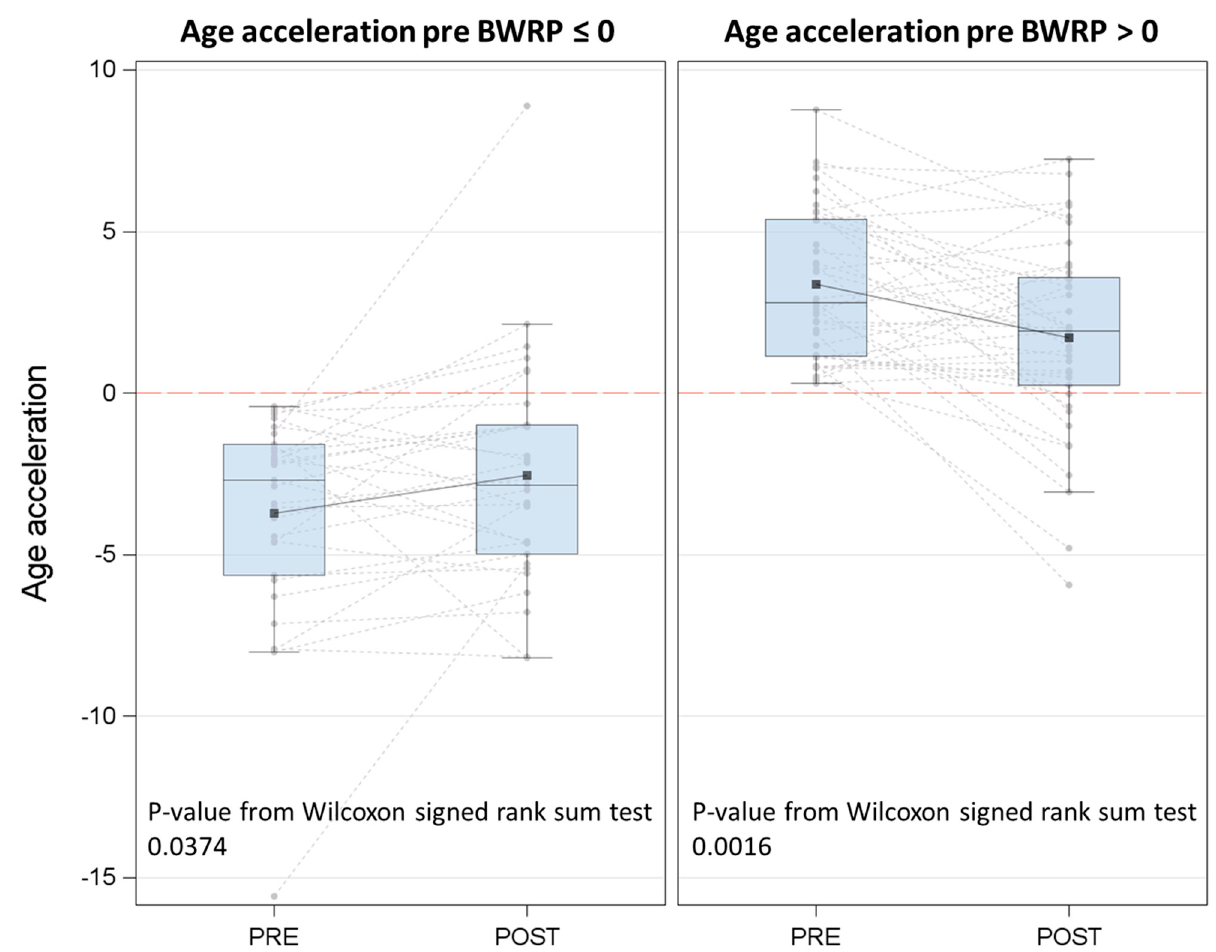
Figure 2. Epigenetic age acceleration: pre- and post-BWRP values are reported as spaghetti and box plots. Population was divided by epigenetic age acceleration at T1 (pre-BWRP: ≤ 0 or >0 yrs).